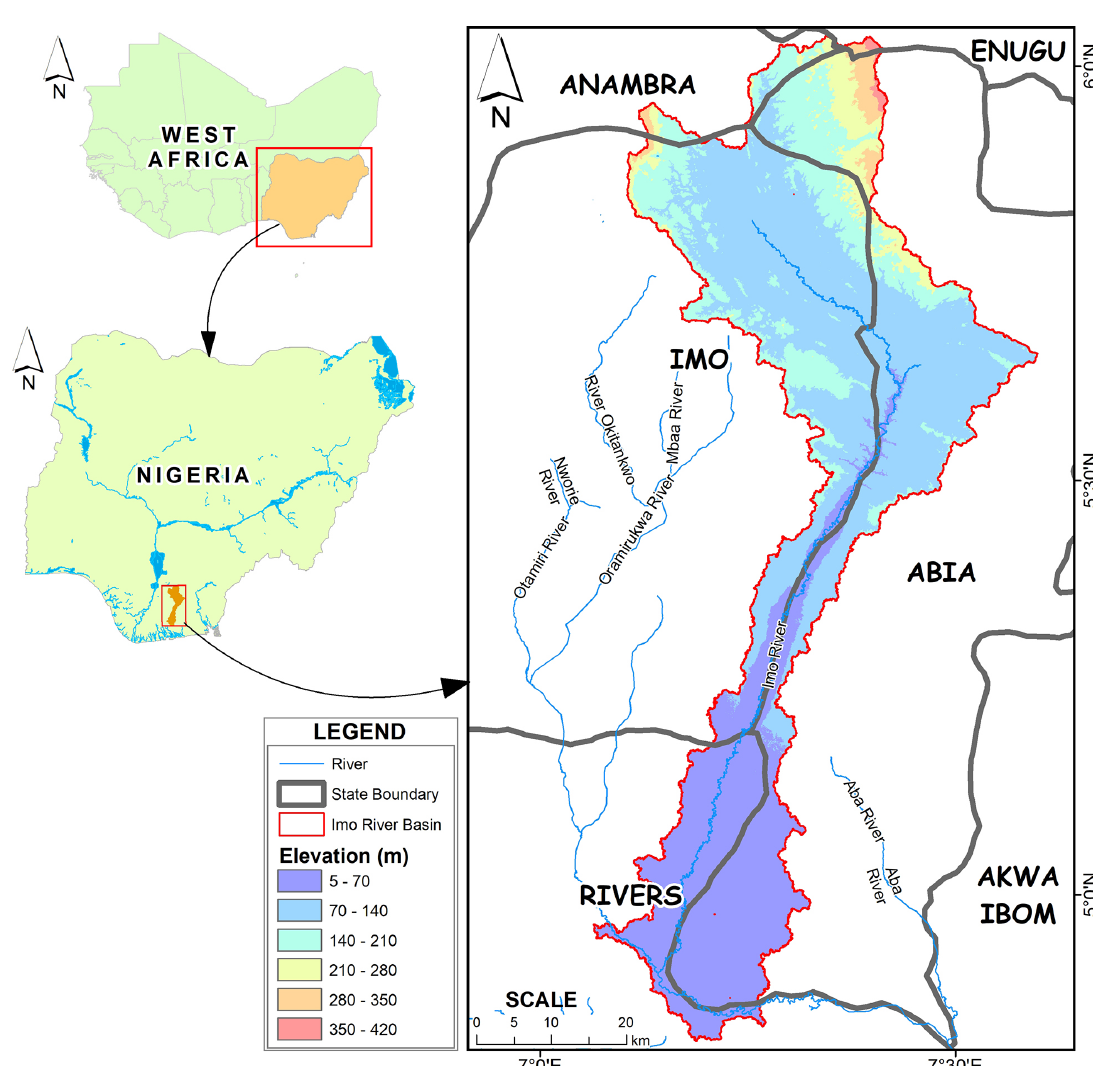
Fig. 1. Map showing the location of the study area.